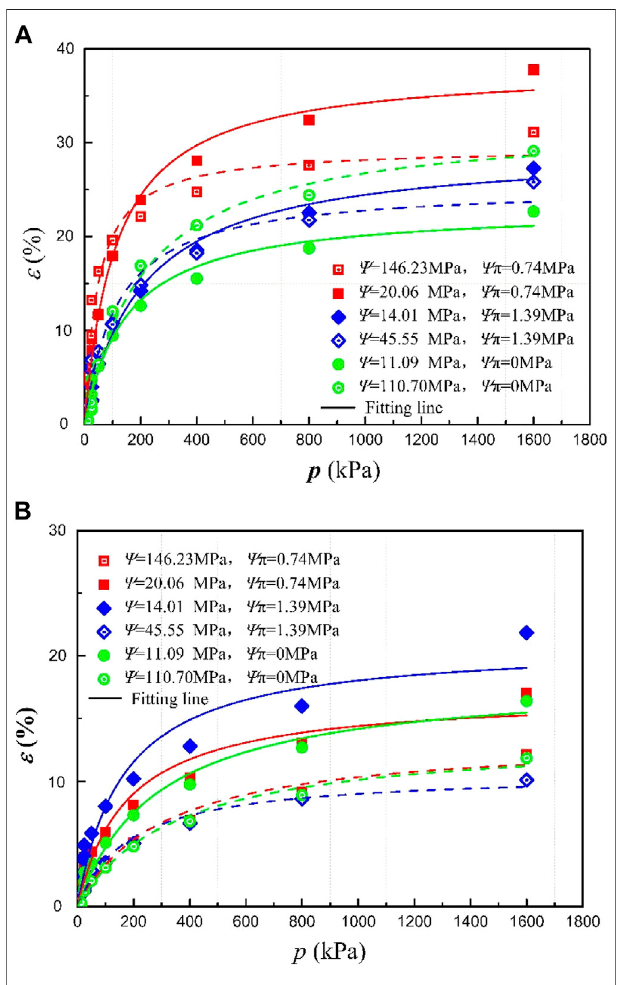
FIGURE 9 | The strain-stress relationships of samples: (A) undisturbed loess; (B) compacted loess.